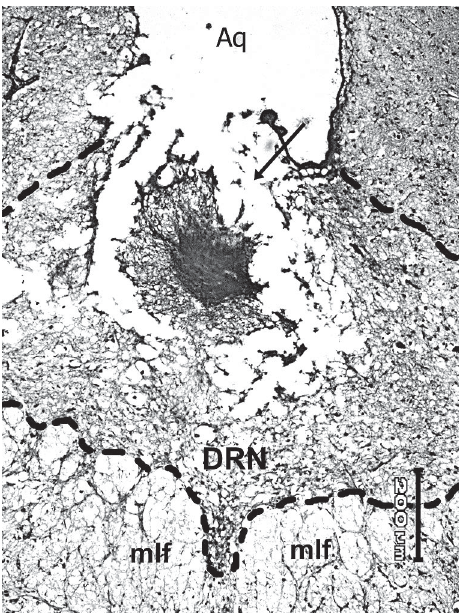
Figure 1. Photomicrograph of a histological section of the en- cephalon, at the level of the mesencephalon. The electrolytic lesion of the dorsal raphe nu- cleus (DRN, delimitated by the traced line) is indicated by the arrow. Aq = aqueduct, mlf = medial longitudinal fasciculus. Nissl,